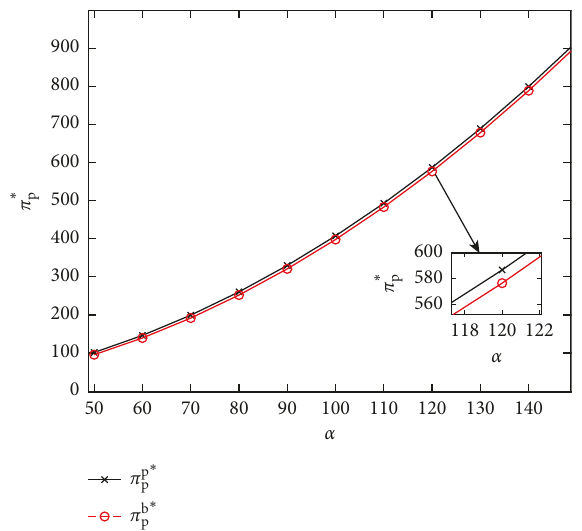
Figure 9: Impact of change in α on the platform’s optimal